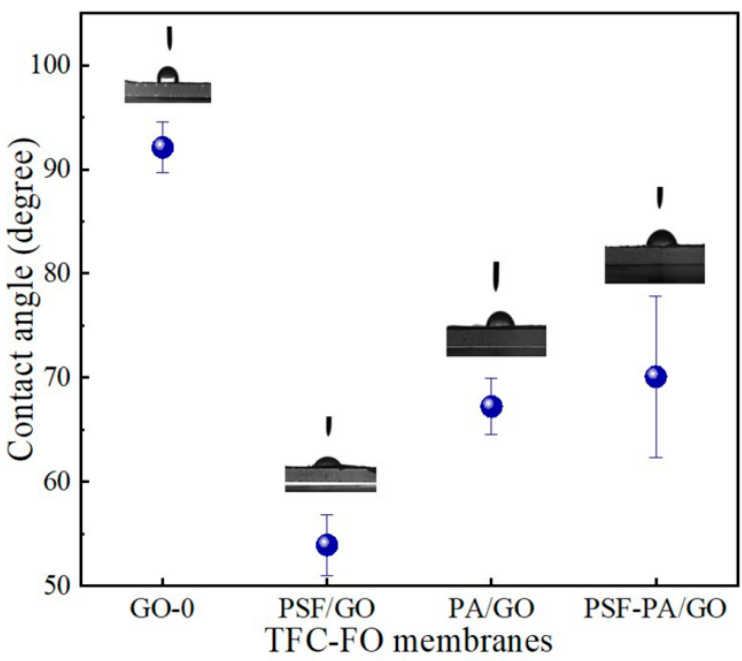
Figure 5. Contact angles of TFC-FO GO-0 , TFC-FO PSF/GO , TFC-FO PA/GO and TFC-FO PSF-PA/GO membranes.